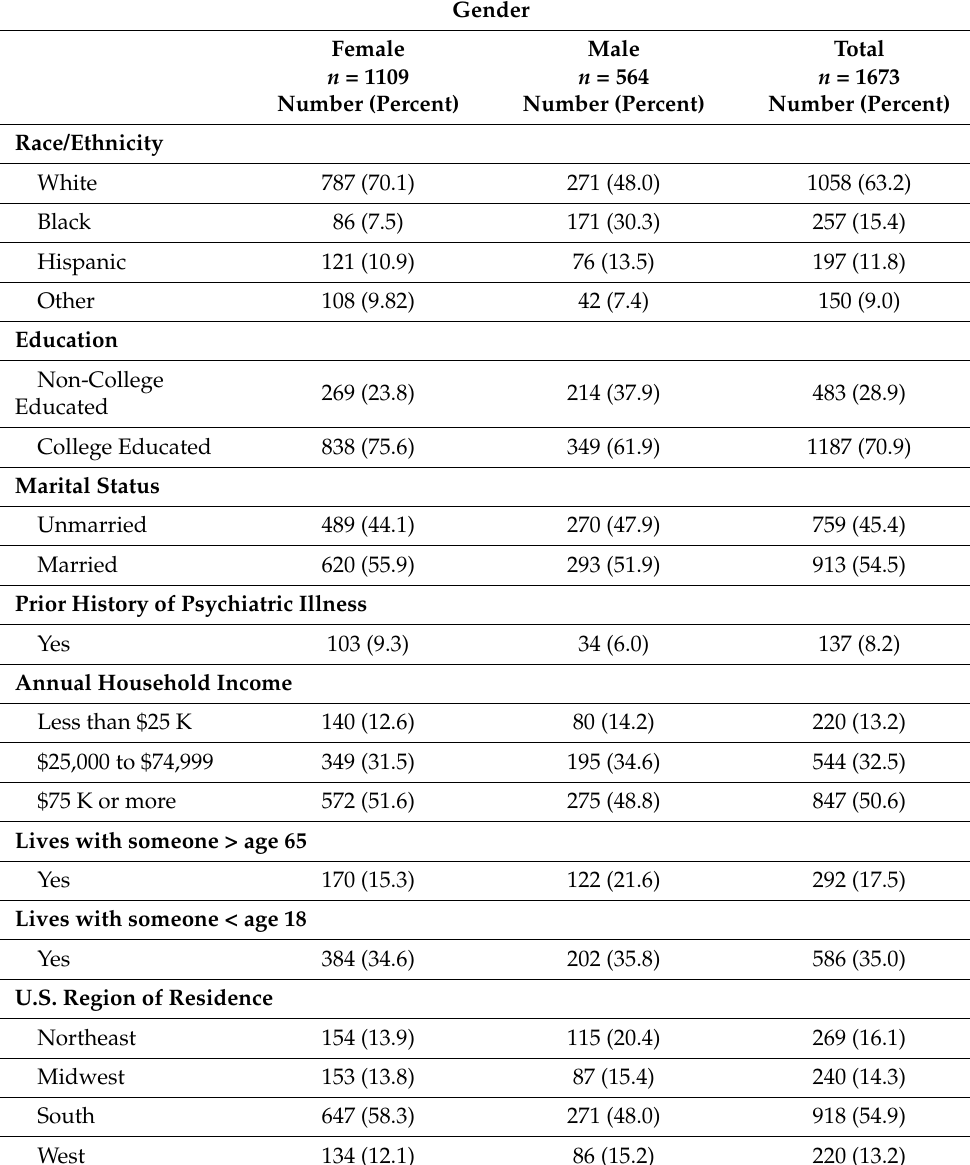
Table 1. Sample Characteristics ( n =